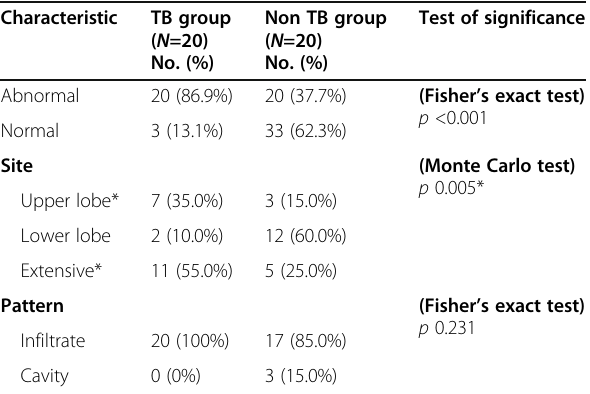
Table 3 Presence of abnormality, site, and pattern of CXR abnormalities in TB and non TB